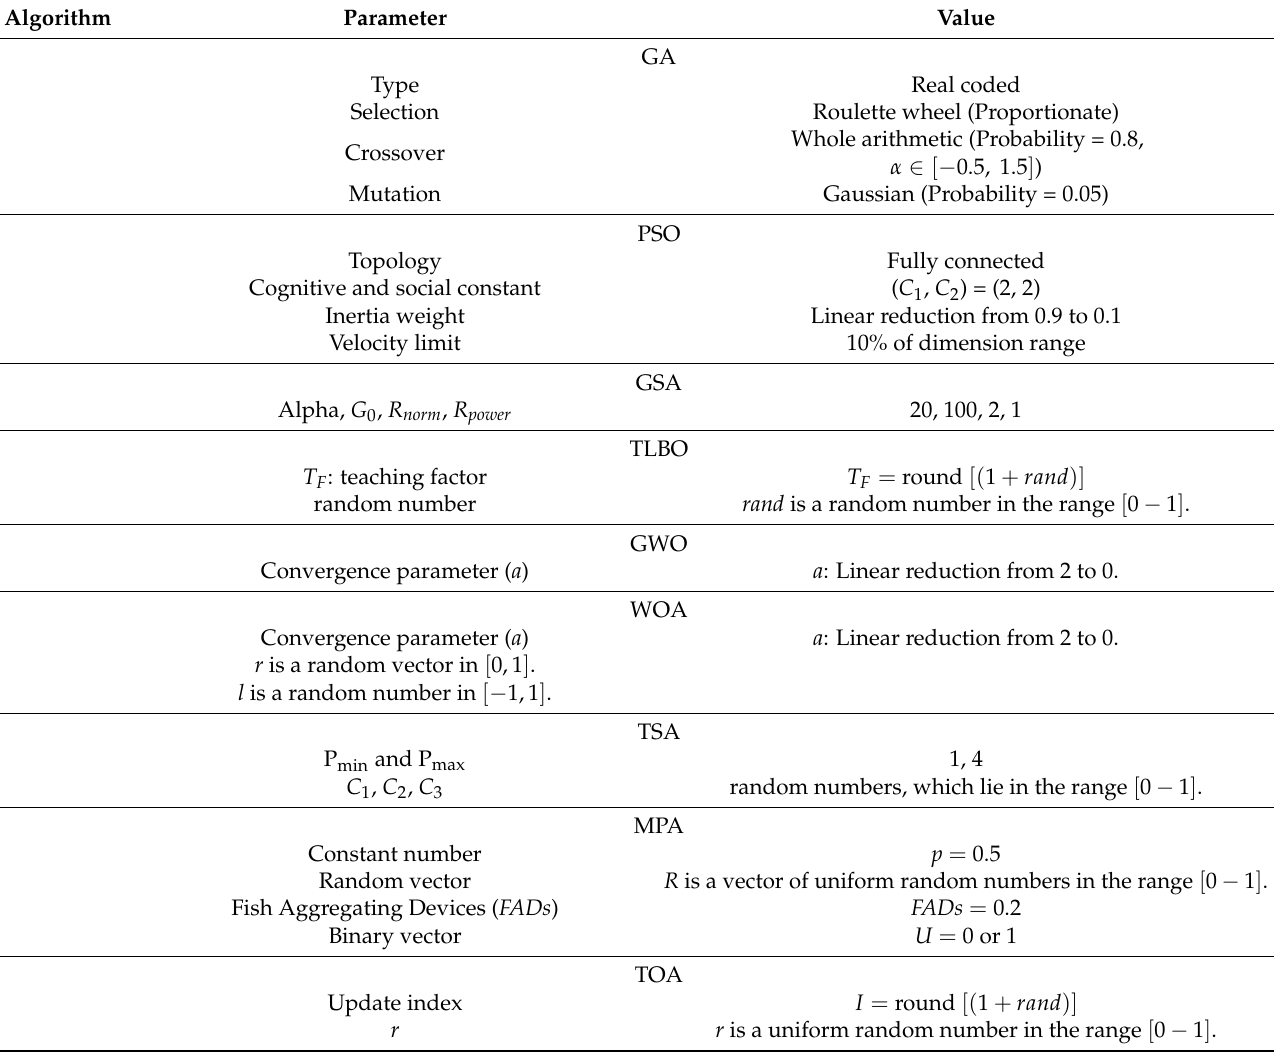
Table 3. Parameter values for the compared